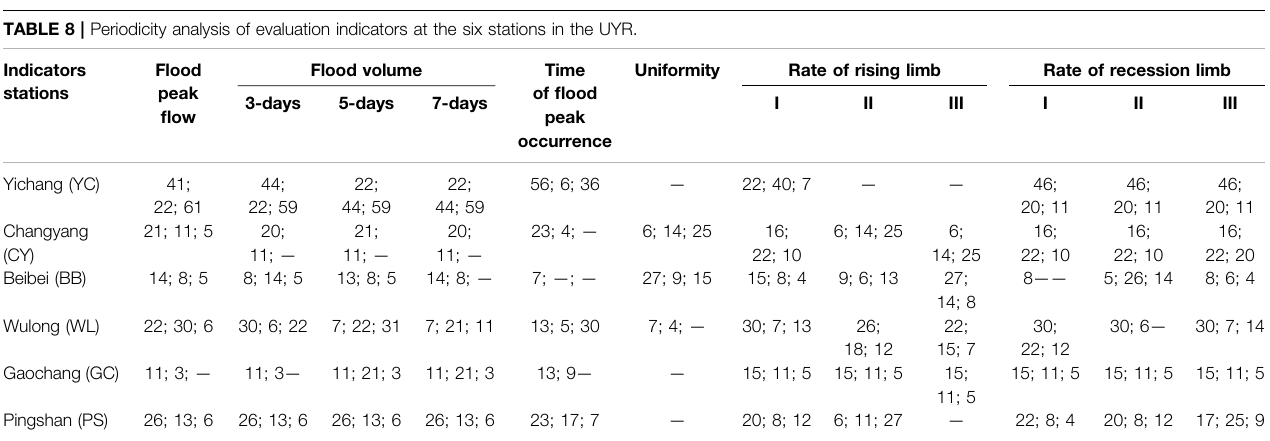
TABLE 8 | Periodicity analysis of evaluation indicators at the six stations in the UYR. Indicators